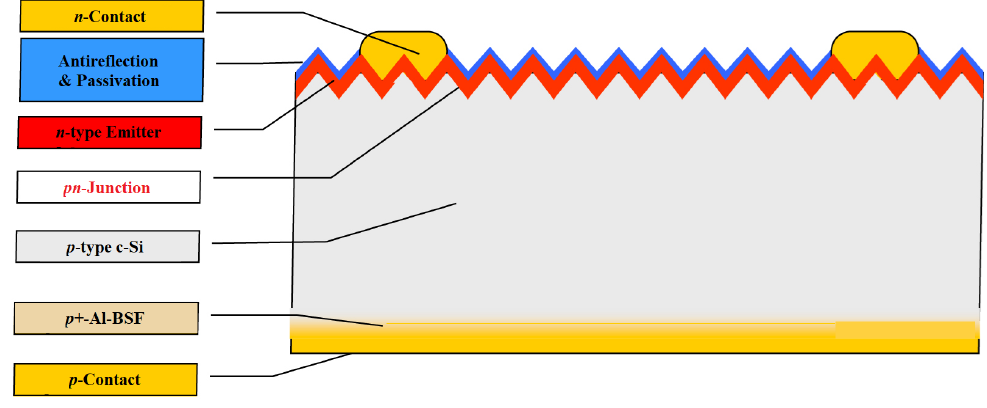
Figure 5. Silicon solar cell structure: Al-BSF [1].